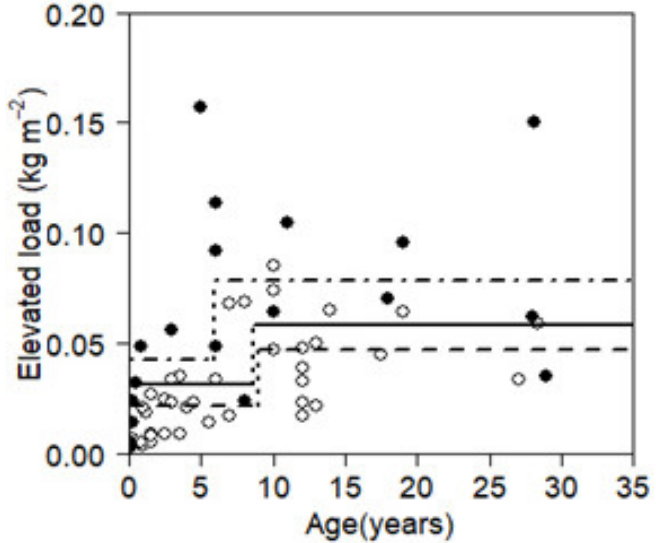
Table 7. In all cases, the parameters have low standard errors compared to the means.